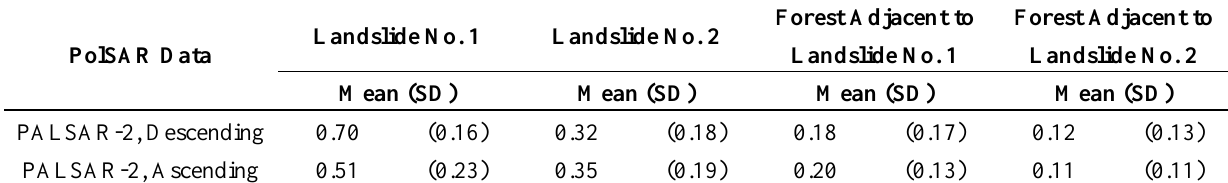
Figure 6. Scattering power decomposition results for PALSAR-2 data in ( a , b ) descending and ( c , d ) ascending orbit observations. Landslide No. 1 (a,c) is on the slope facing toward the radar as contrasted to landslide No. 2 (b,d), which is on the slope facing away from the radar. The values of P s for landslides (L) and those of neighboring forest (F) were sampled in the white rectangles on the images. Table 2. Statistics of the normalized surface scattering power p s in landslides and those of neighboring